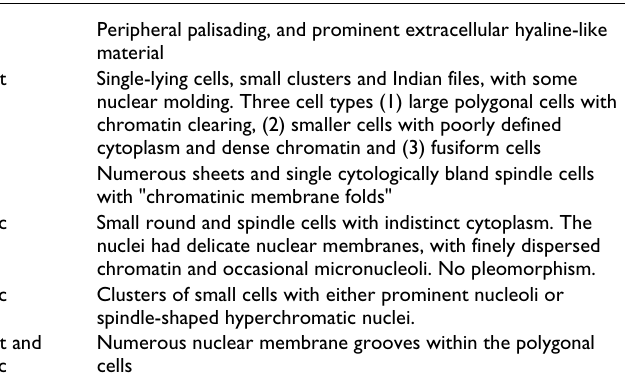
Table 5: Cytopathology of Adamantinoma Author